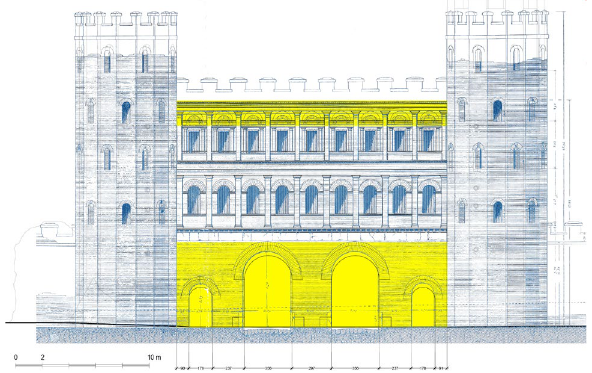
Figure 13 . Superimposition of the actual survey (in black) on the elevation drawn by Promis (in light blue). In yellow are highlighted the parts where there is a lack of correspondence between the drawings © M.